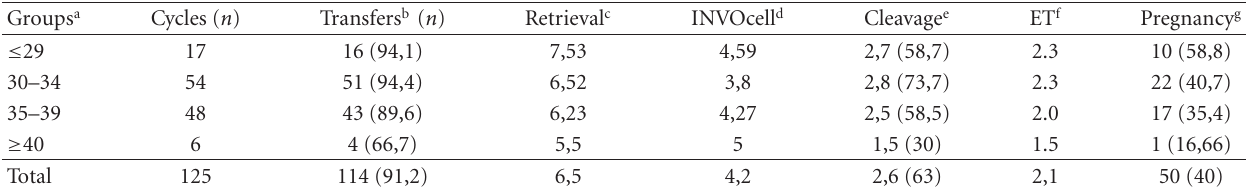
Table 1: Summary of results from the INVO